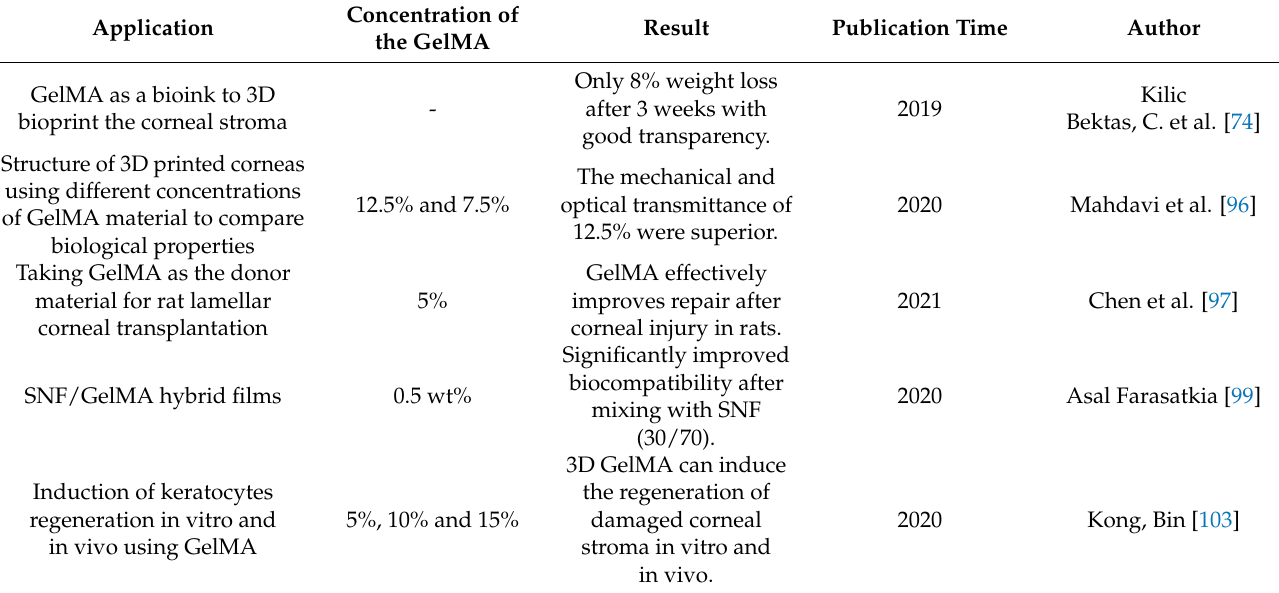
Table 4. Application of GelMA material in keratocytes in recent